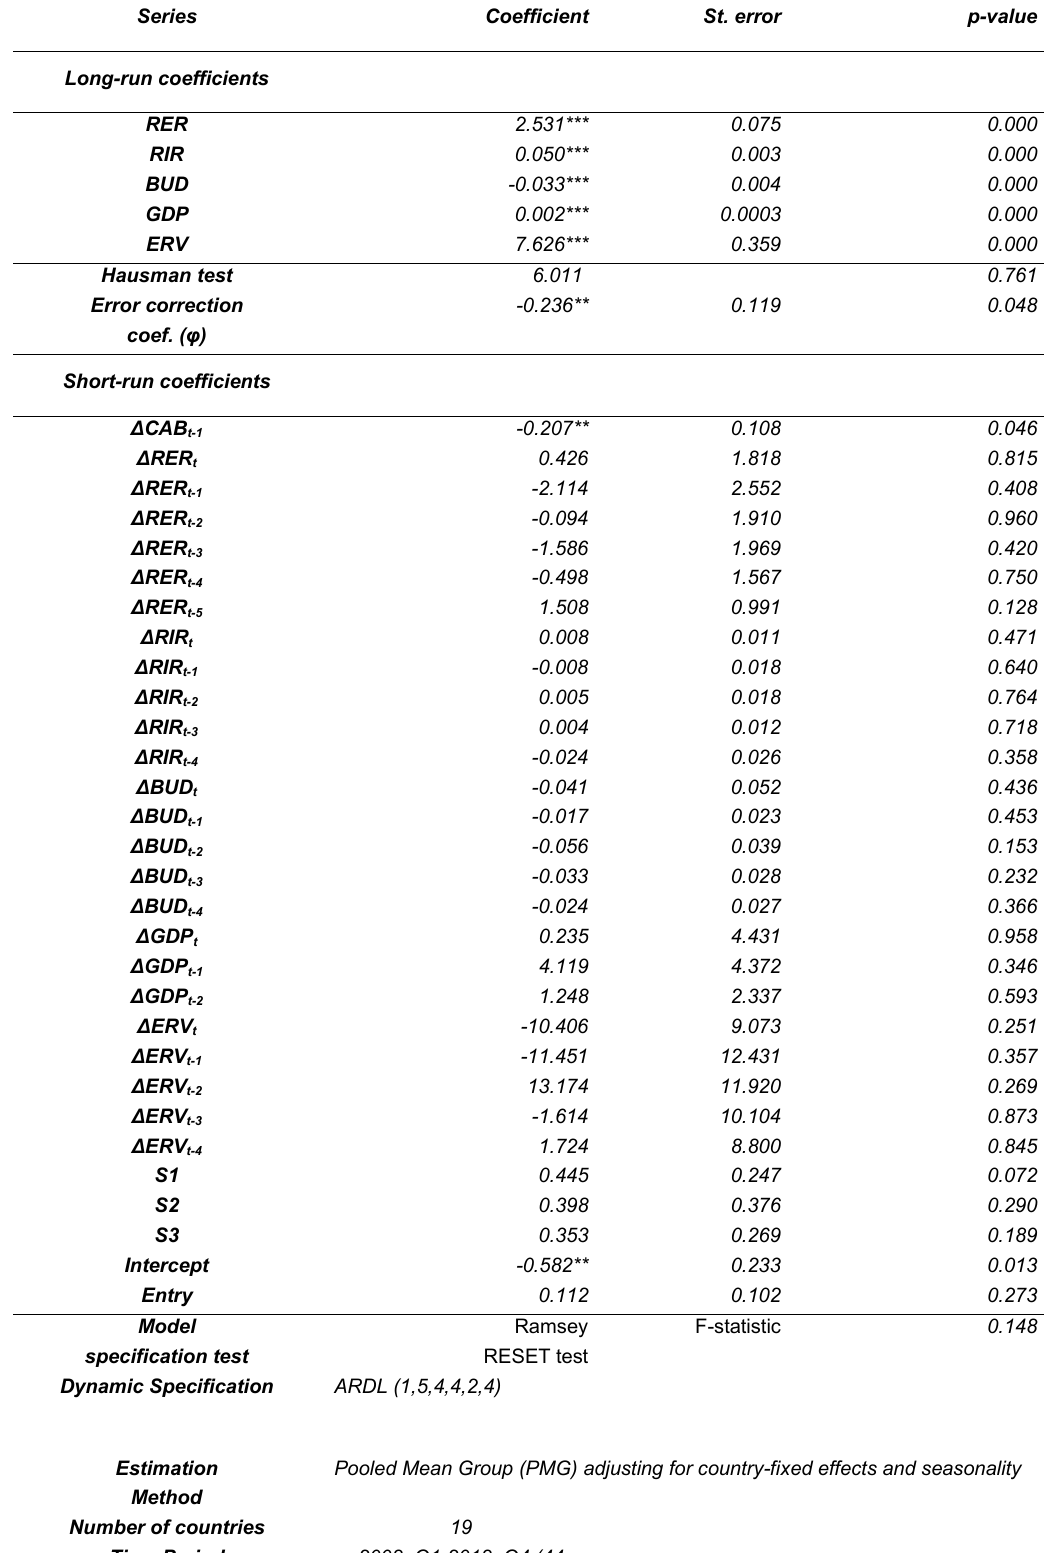
Table 6. Long-run and Short-run coefficients of the Current Account Balance determinants, ARDL (1,5,4,4,2,4).